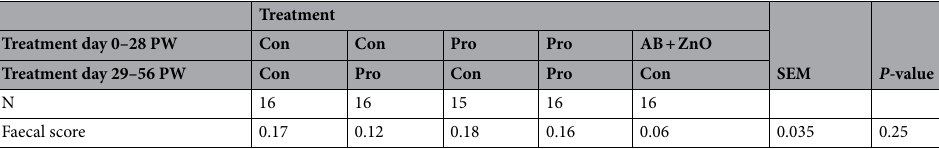
Table 2. Effect of Bacillus altitudinis WIT588 spore supplementation to 1st stage and/or 2nd stage weaner diets and antibiotic (AB) + ZnO supplementation to 1st stage weaner diets on faecal scores 1 . PW, post-weaning; Con, control; Pro, probiotic; AB + ZnO, antibiotic + zinc oxide. 1 Least square means and pooled standard errors of the mean (SEM). Faecal scores were performed visually every day between weaning and day 28 PW and the mean was used for the analysis. The scoring system was as follows; 0 = normal dry, pelleted faeces; 1 = soft faeces with shape; 2 = very soft faeces with liquid (mild diarrhoea); and 3 = watery or bloody faeces (severe diarrhoea). Data were analysed as repeated measures using the mixed model procedure in SAS with the pig being the experimental unit. Differences in least square means were explored using the t -test after Tukey adjustment for multiple comparisons.